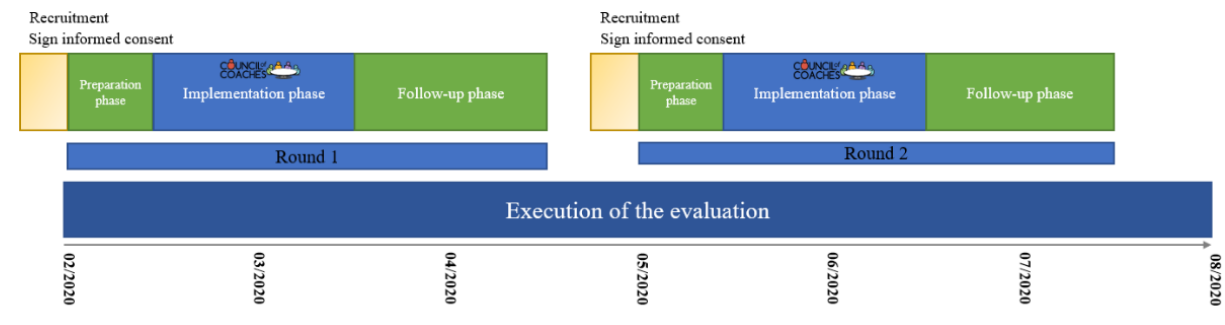
Figure 4. Timeline of the study evaluation